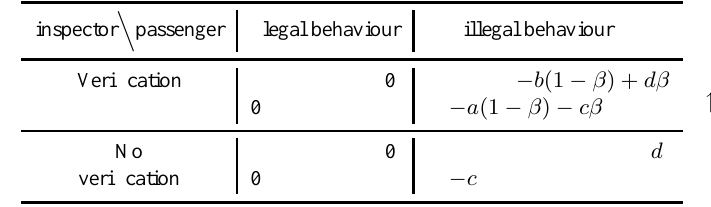
Table 2. Normal form of the two person game between a State (inspectee) and the verification authority (inspector). False alarms are not possible. The arrows indicate the preference directions of the two players if (3.4) is fulfilled.